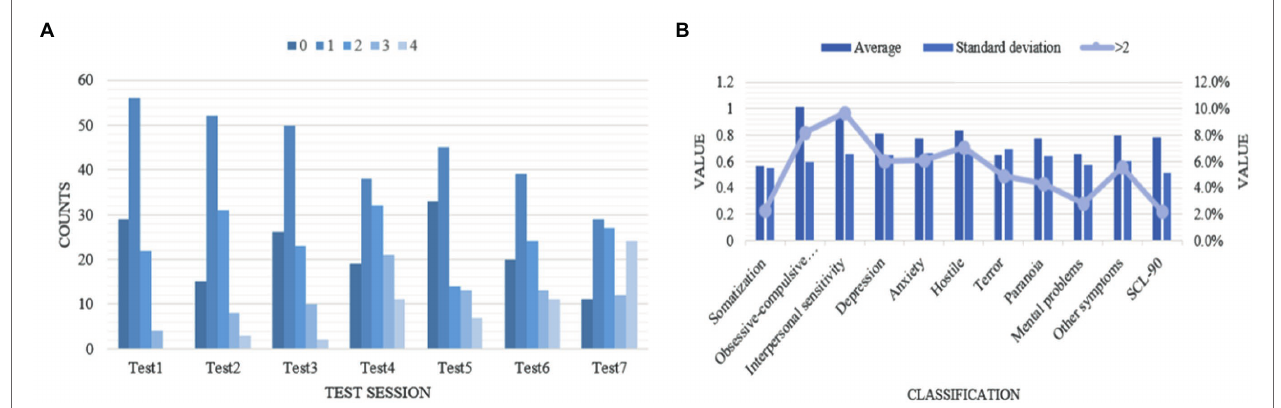
FIGURE 1 | Performance and scores under mental health. (A) Subjective scores. (B) Mental